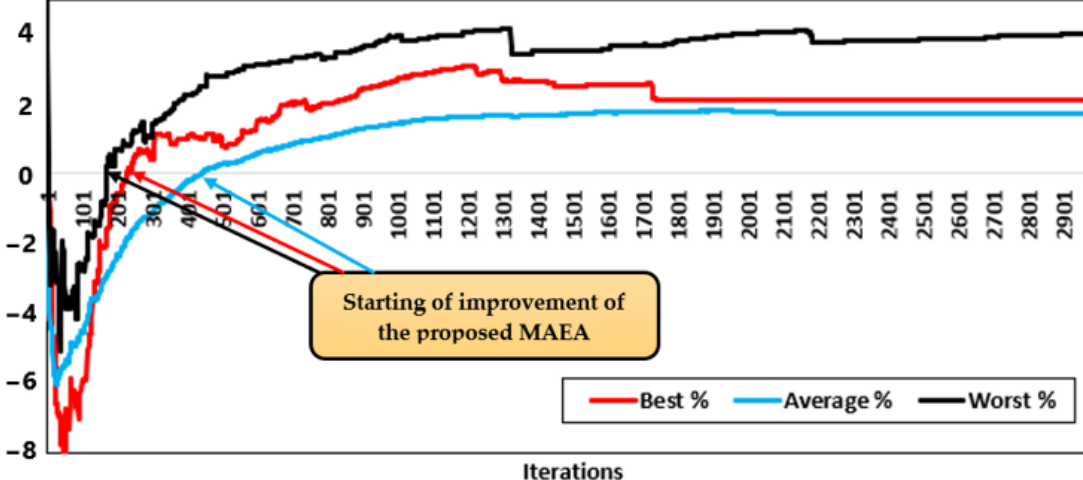
Figure 12. Percentage difference for the best, worst run, and the average of all runs of the MAEA and AEA of Case 3. Table 9. Optimal operational settings and related costs of the proposed MAEA and the basic AEA of Case